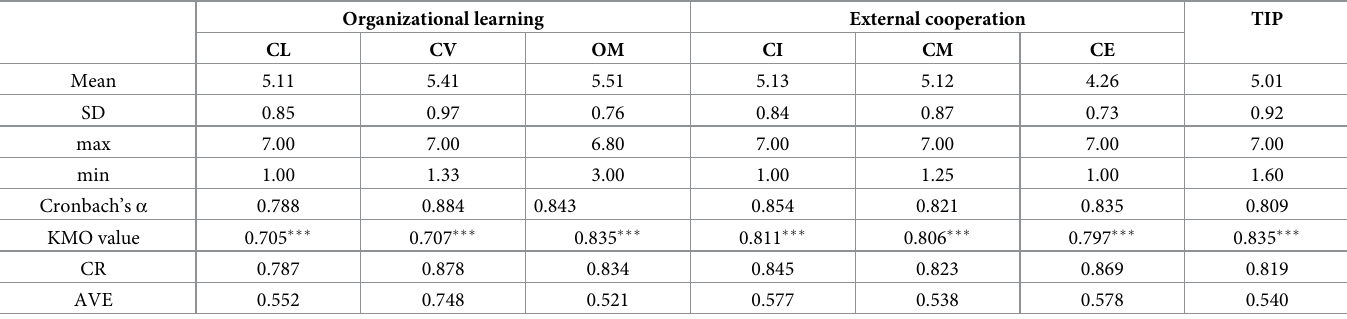
Table 2. Reliability and validity analysis.